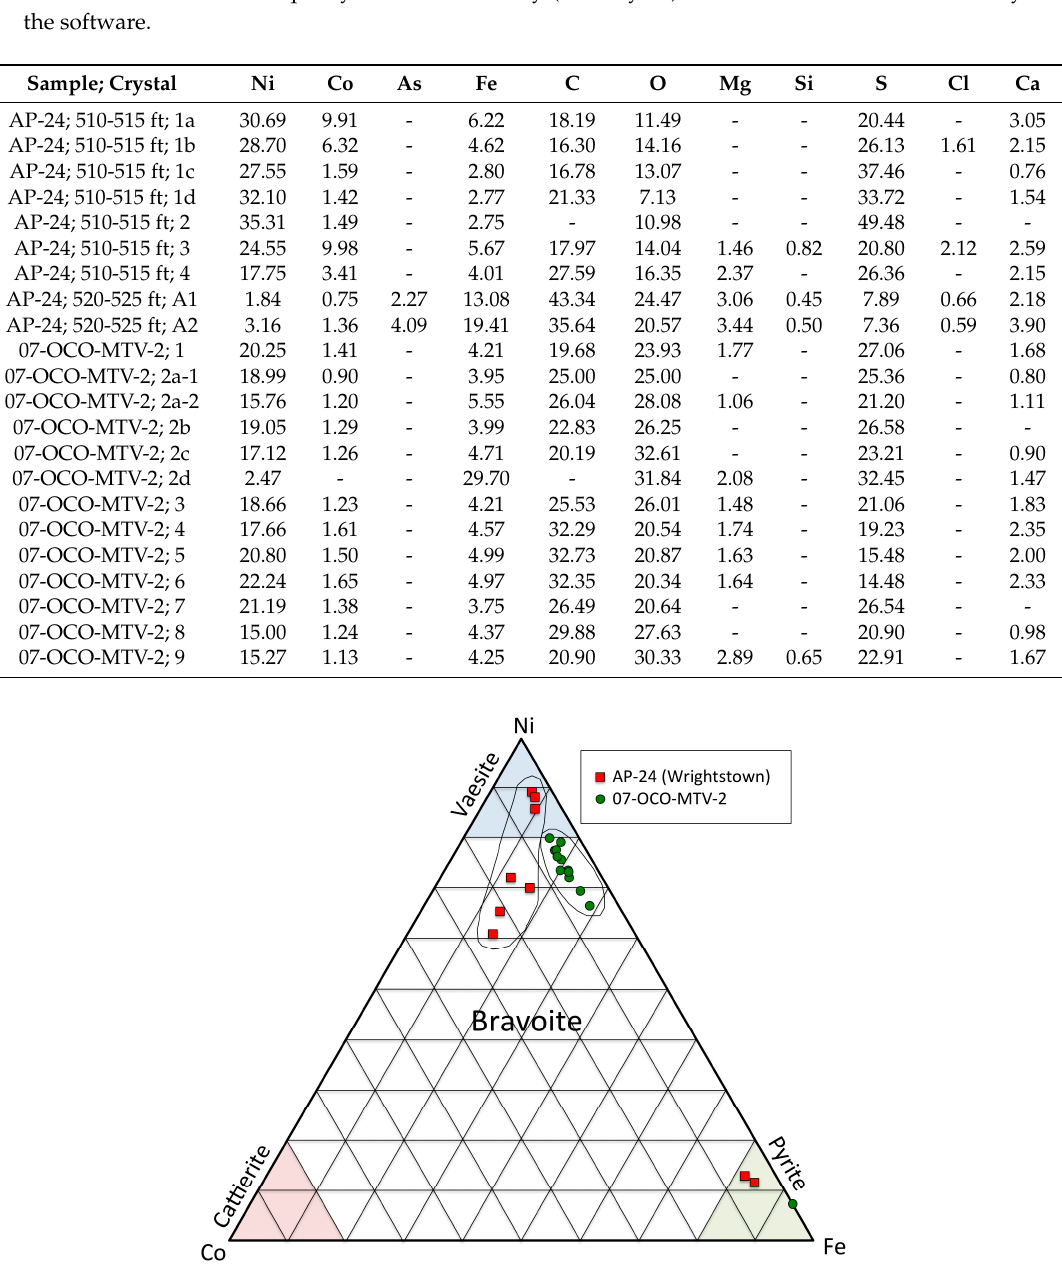
Figure 11. Ternary plot of mole percent normalized compositions indicating the relative proportions of nickel, cobalt, and iron for various members of the pyrite group. Data are for samples listed in Table 1. Red squares are for samples AP-24 (Locality 83), and green circles are for 07-OCO-MTV-2 (Locality 39). Region of bravoite, along with end members pyrite, vaesite, and cattierite are shown, as described by Kerr [53].